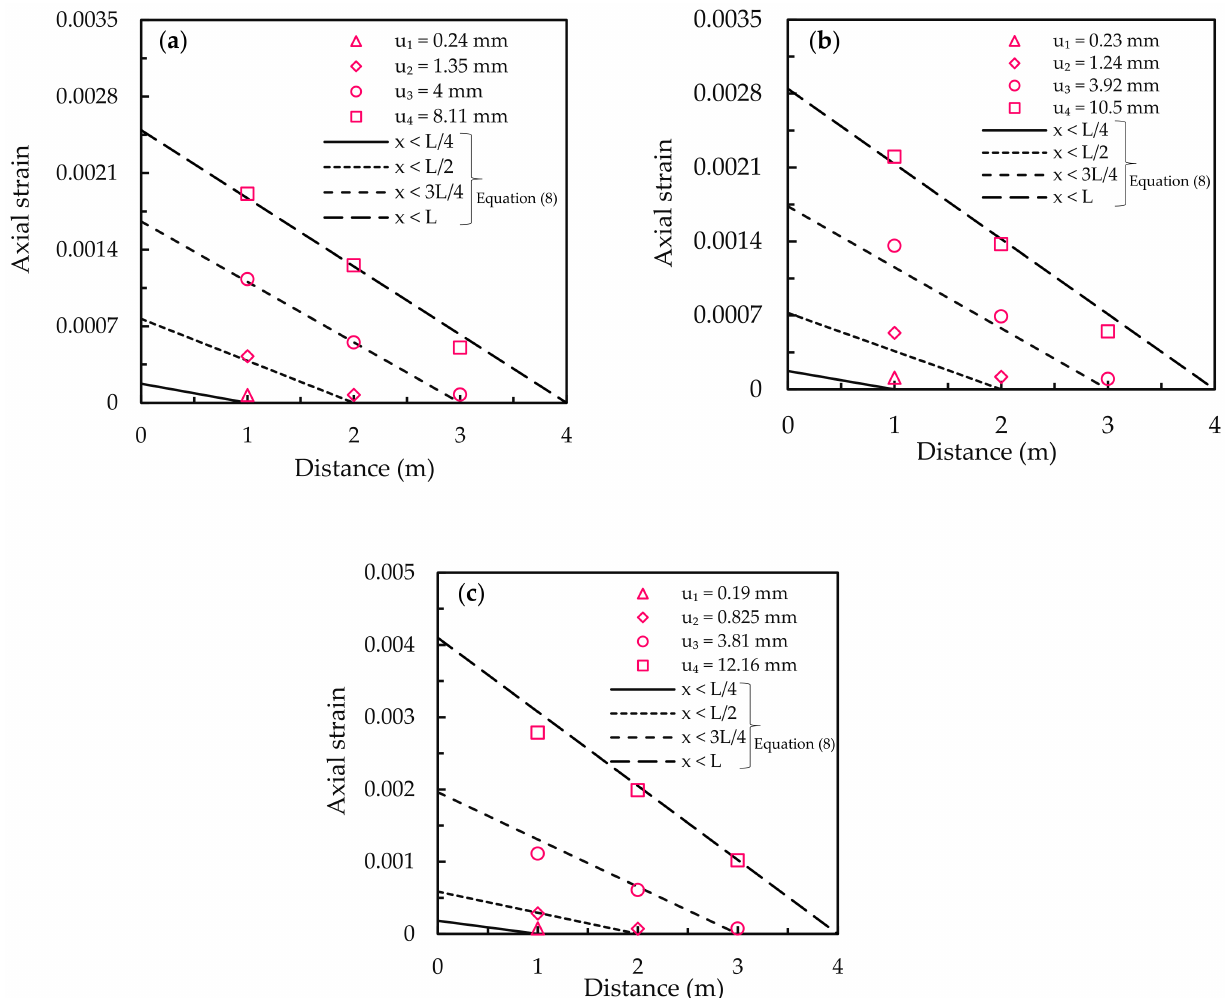
Figure 10. Comparison of experimental strains with calculations using the simplified method for ( a ) T1; ( b ) T4; and ( c ) T3. u 1 , u 2 , u 3 , and u 4 are the leading end displacements when the axial force is mobilized to the distance of 1, 2, 3, and 4 m (trailing end), respectively, from the leading